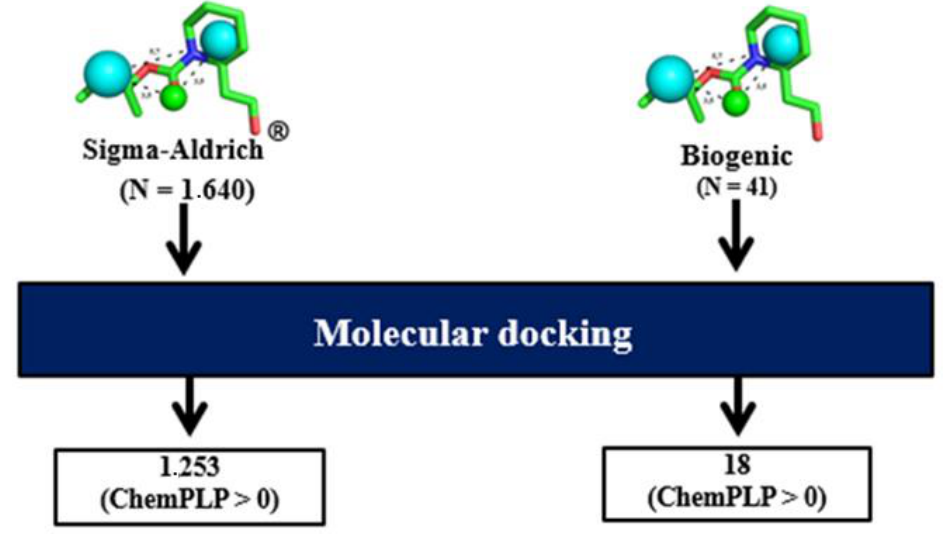
Figure 2. Docking-based virtual screening step.